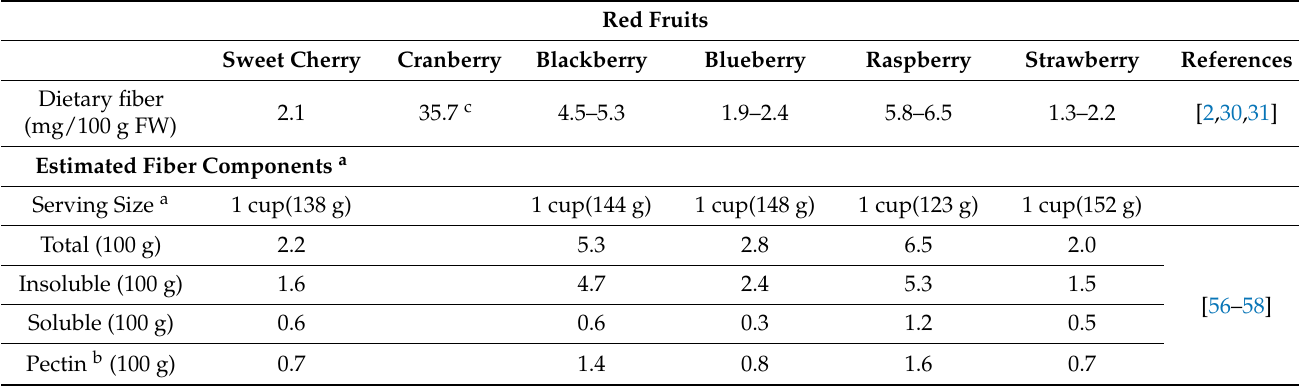
Table 4. Dietary fiber of some red